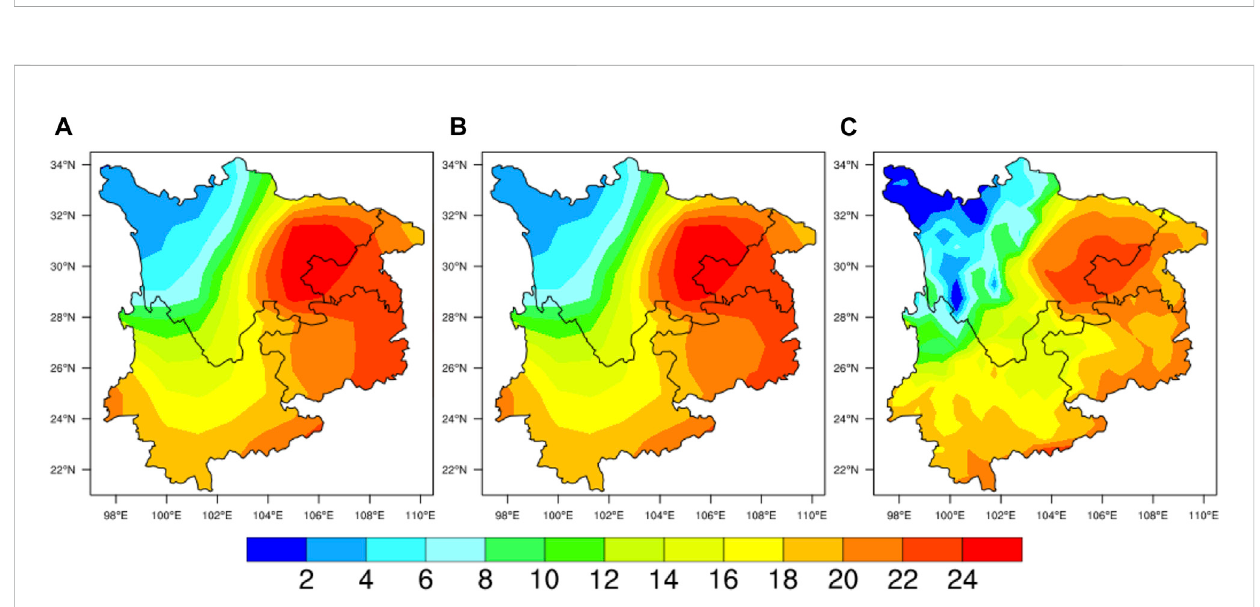
FIGURE 4 The 2-m air minimum temperature (T min ) results for southwest China from 1992 to 2013 in the boreal summer (JJA): (A) control modeling results without AHR; (B) modeling results with AHR; (C) CRU data results (unit: ° C).